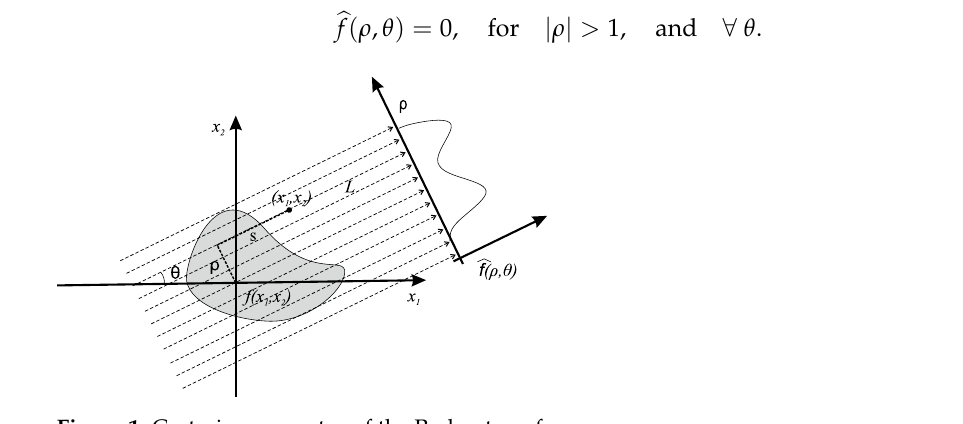
Figure 1. Cartesian geometry of the Radon